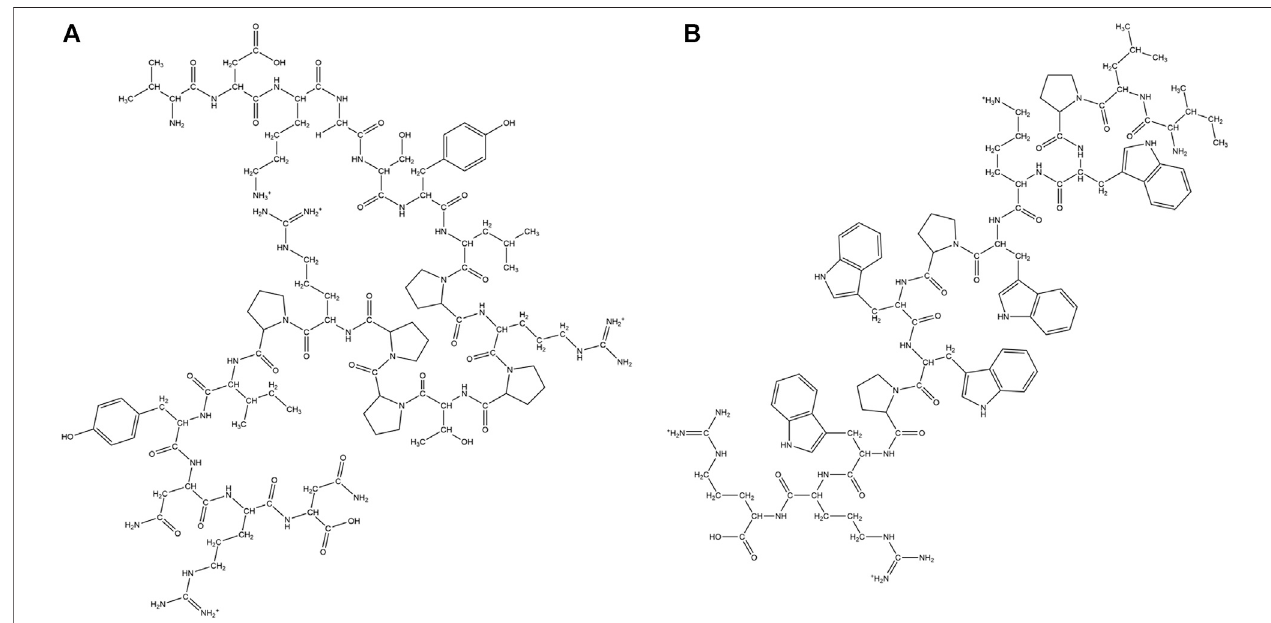
FIGURE 5 | Examples of natural AMPs rich in Pro and Trp amino acid residues. (A) Pro rich AMP: Pyrrhocoricin. (B) Trp rich AMP: Indolicine.